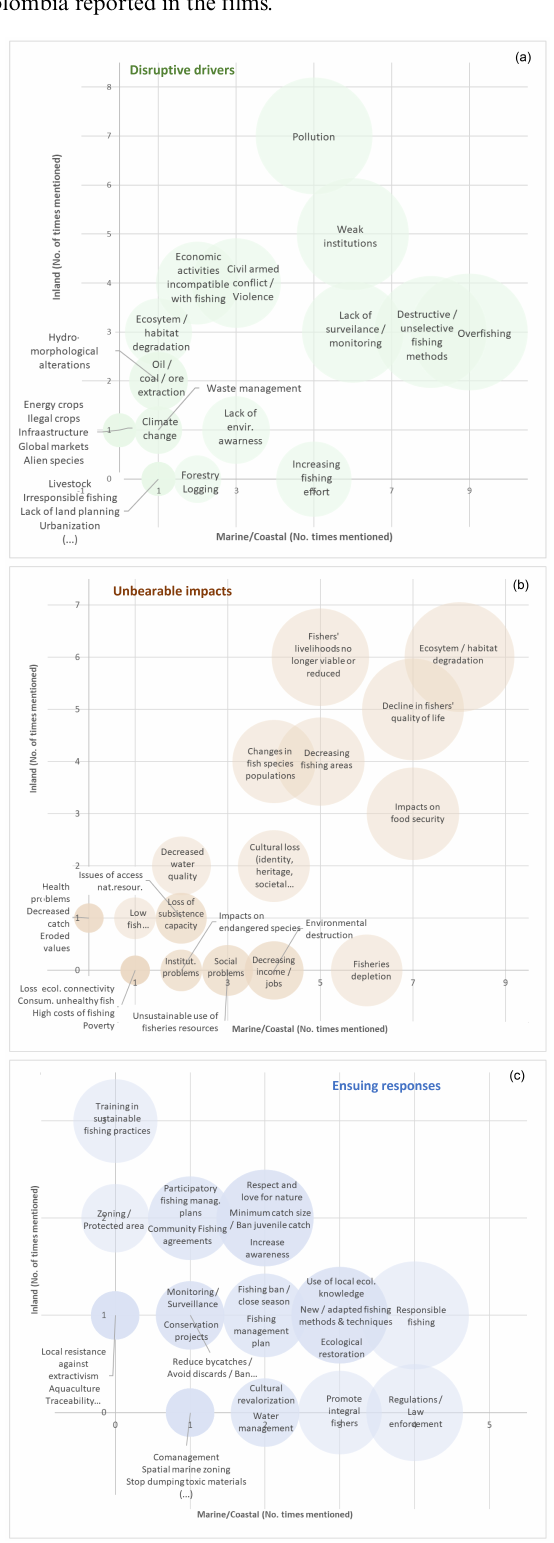
Fig. 2 . Drivers-pressures (a), impacts on (b), and responses (c) to unwanted developments in the small-scale fisheries sector of Colombia reported in the